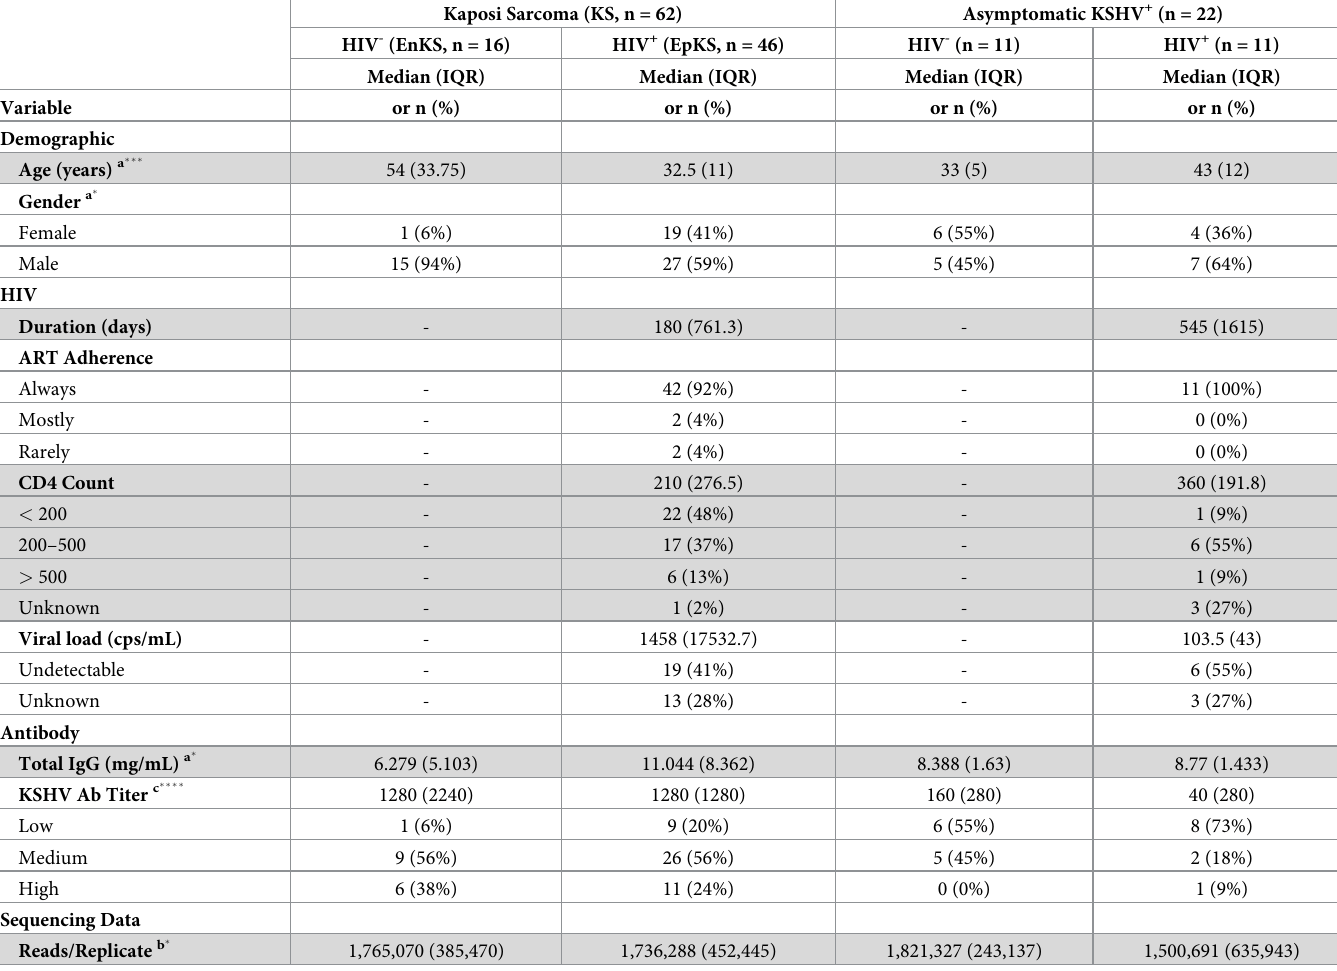
Table 1. Cohort demographics (N = 84). Significant comparisons are denoted: a EnKS vs. EpKS, b Asymptomatic HIV - vs. HIV + , c KS vs. Asymptomatic. P-values are denoted: ���� p < 0 . 0001 , ��� p < 0 . 001 , �� p < 0 . 01 , � p < 0 .